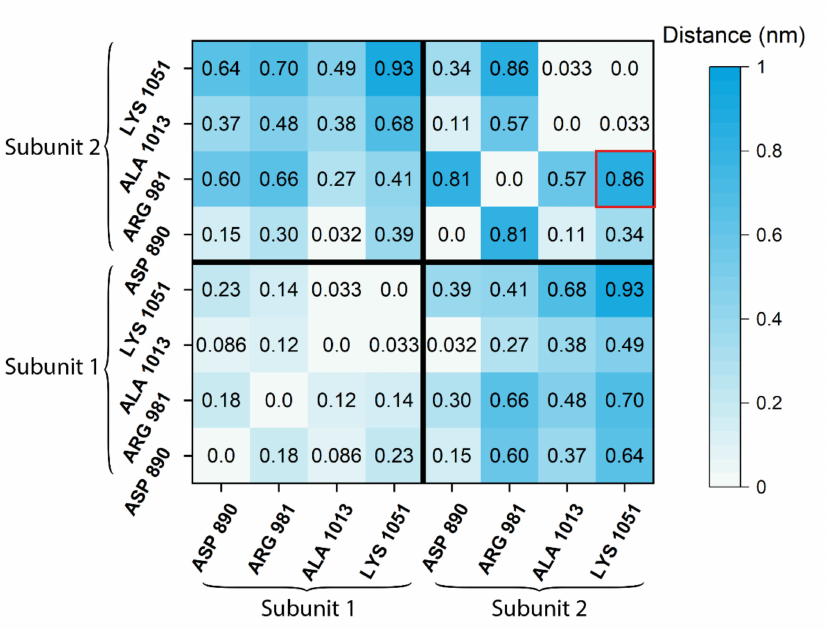
Figure 7. Difference distance matrix for binding-site residues. The eight residues comprising the binding site are shown in a symmetric difference distance matrix, which quantifies the change in distance throughout the simulation duration between the wild type and the V907L mutant of the bovine GC-E. The first four residues belong to the first subunit, while the last four belong to the second. The lower-left and upper-right submatrices compare distances within a subunit, while the bottom right shows the differences beyond the individual subunits. For instance, the highlighted entry (red square) indicates that the average change in distance from Lys1051 to Arg981 from the second subunit is 0.86 nm when comparing the wild type to the mutant.